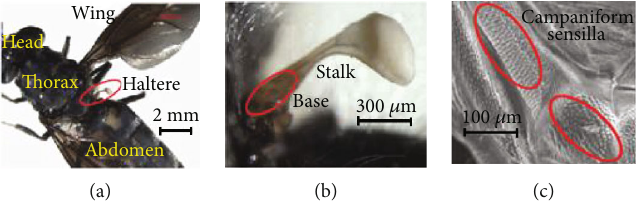
Figure 2: (a) A picture of a soldier fl y showing the head, thorax, abdomen, wing, and haltere. (b) A closer view of the haltere. (c) SEM image of the haltere